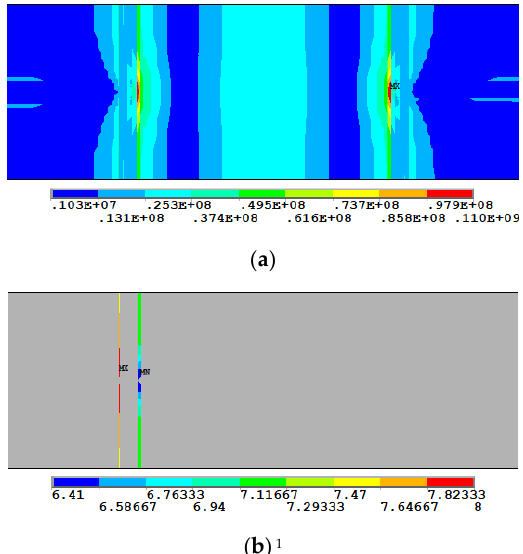
Figure 11. Mises stress of the bottom side of the top flange of the weld seam of a large root. ( a ) Mises stress diagram of the bottom side of the bridge deck (Pa) ( b ) fatigue cyclic life of the connection of the rib-to-deck, 1 the number in the contours is the base 10 log of the contour line. Figure 12 shows the equivalent structural stress of the weld toe for Large-Weldline1 and Large- Weldline2 . The equivalent structural stress of Large-Weldline1 and Large-Weldline2 indicate that the top side of the bridge deck was mainly subjected to the normal compressive stress and the bottom of the bridge deck was subjected to the normal tensile stress. The bending structural stress was more